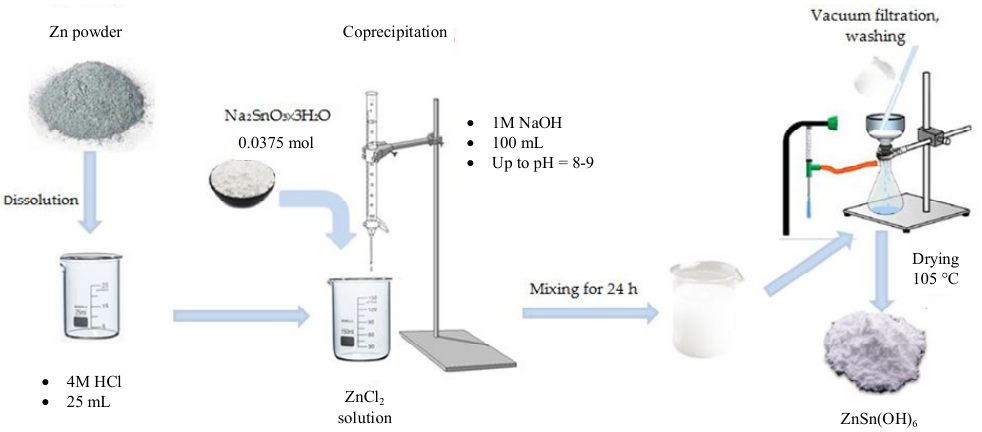
Figure 1. Synthesis scheme of the precursor.